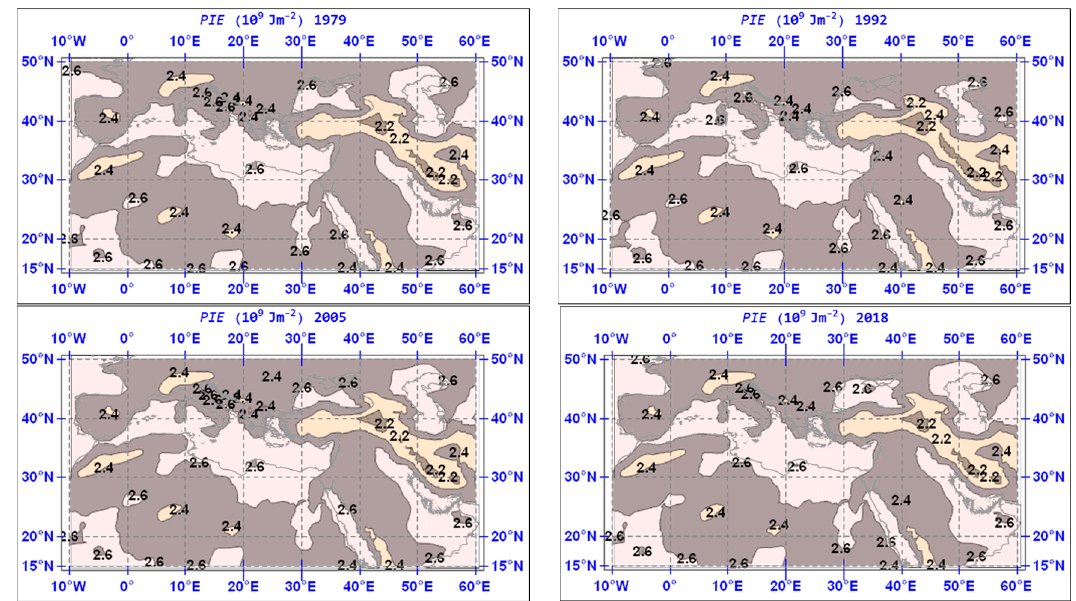
Figure 10. Same as Figure 4 but for PIE . Isopleths are drawn for every 0.2 × 10 9 Jm − 2 .